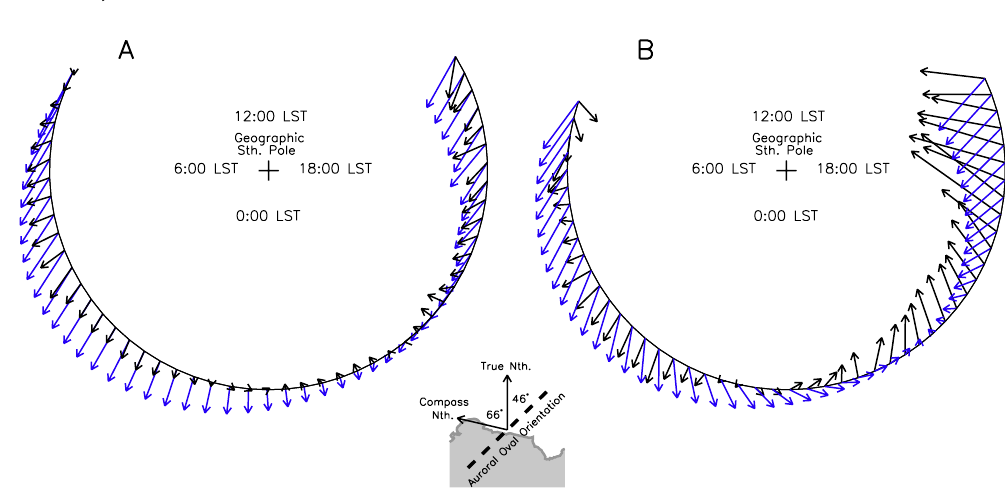
Fig. 7. (A) Dial-type representation of Fig. 6, showing average winds observed under all geomagnetic and solar conditions, which for this data set is representative of a quiet night at solar minimum. (B) Dial-type representation of Night B (active conditions), shown for comparison with the average, geomagnetically quiet night shown in (A). In both plots, black arrows show observed (averages in plot A) wind direction, blue arrows show HWM93 model winds, in geographic coordinates. Local solar time increases clockwise around the dial. The sun is to the top of the figure. The small map underneath shows the geographic north and compass north directions, relative to the Mawson coastline, as well as the orientation of the auroral oval relative to these